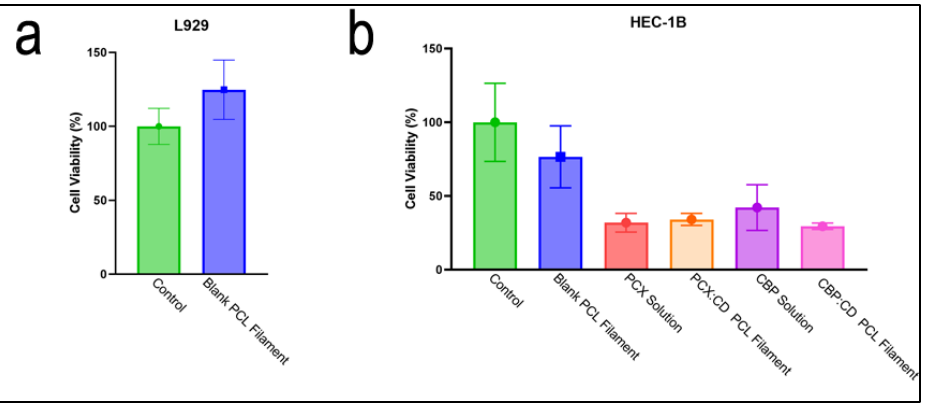
Figure 10. Cell viability of ( a ) drug-free filament on L929 mouse fibroblast and ( b ) drug-free filament, drug-loaded filament and drug solution on HEC-1B human endometrial adenocarcinoma cell line.